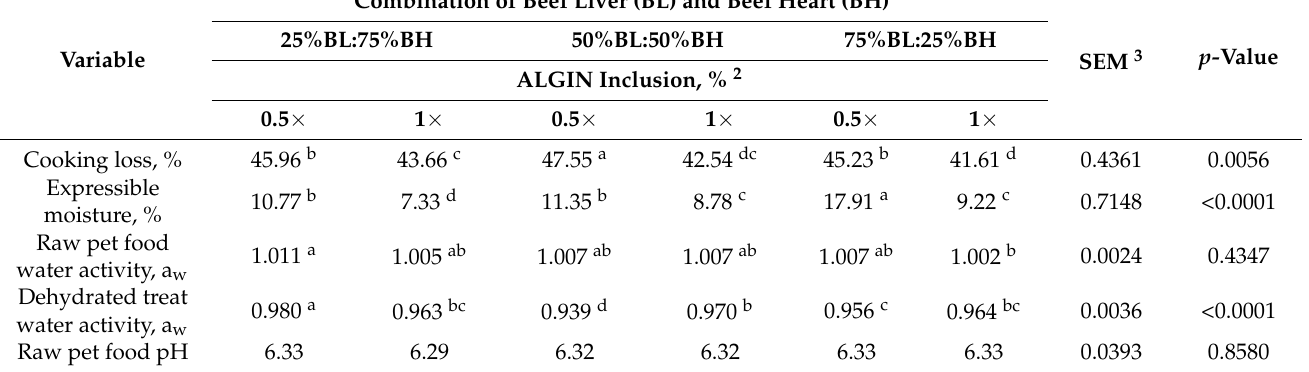
Table 2. Effect of beef liver (BL) and beef heart (BH) combination and sodium alginate + encapsulated calcium lactate (ALGIN) inclusion on cooking loss, expressible moisture, water activity, and pH of raw pet food and dehydrated pet treats.